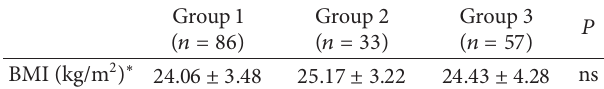
Table3:Bodymassindex(BMI)oftype1diabeticpatients( 𝑛 = 176 ) divided into three groups according to diabetic retinopathy status.